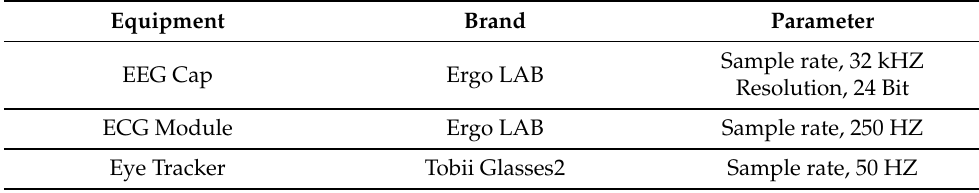
Table 4. Physiological signal acquisition equipment parameters.